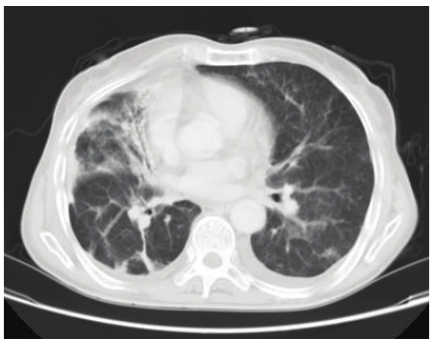
Figure 1: Chest computed tomography: bilateral interstitial thick- ening and bronchiectasis in the right hemithorax.